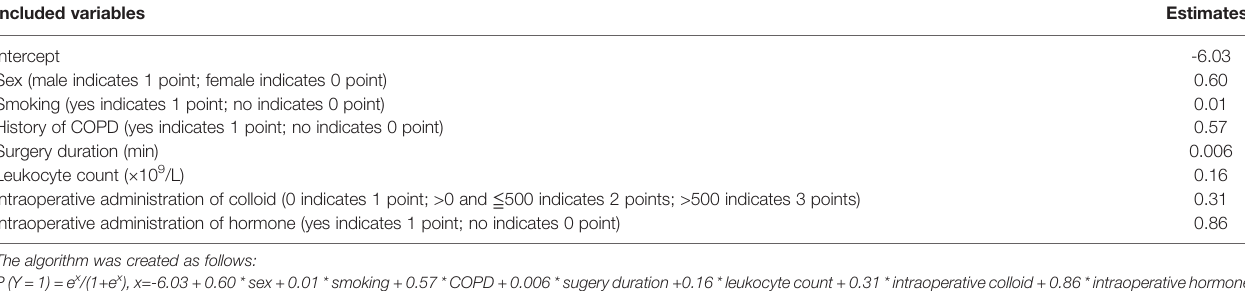
TABLE 2 | An algorithm to predict postoperative pneumonia among elderly patients with lung cancer after video-assisted thoracoscopic surgery. Included